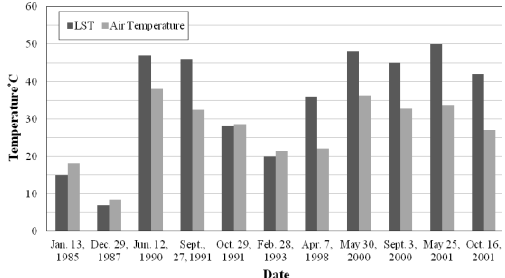
Figure 10. Comparison between the LST and the Air Temperature for the Al-Jleeb